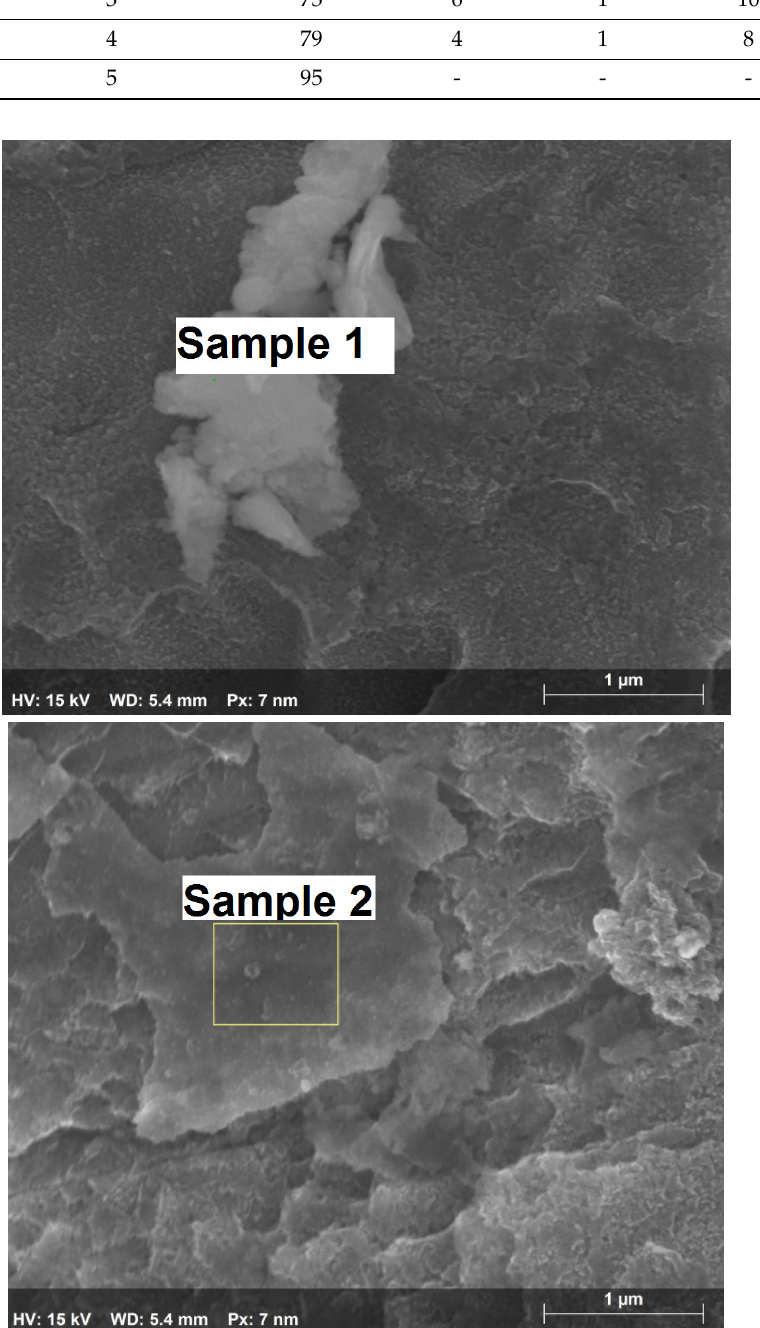
Figure 5. Images of the selected crystallites (sample numbering corresponds to that in Table 1).